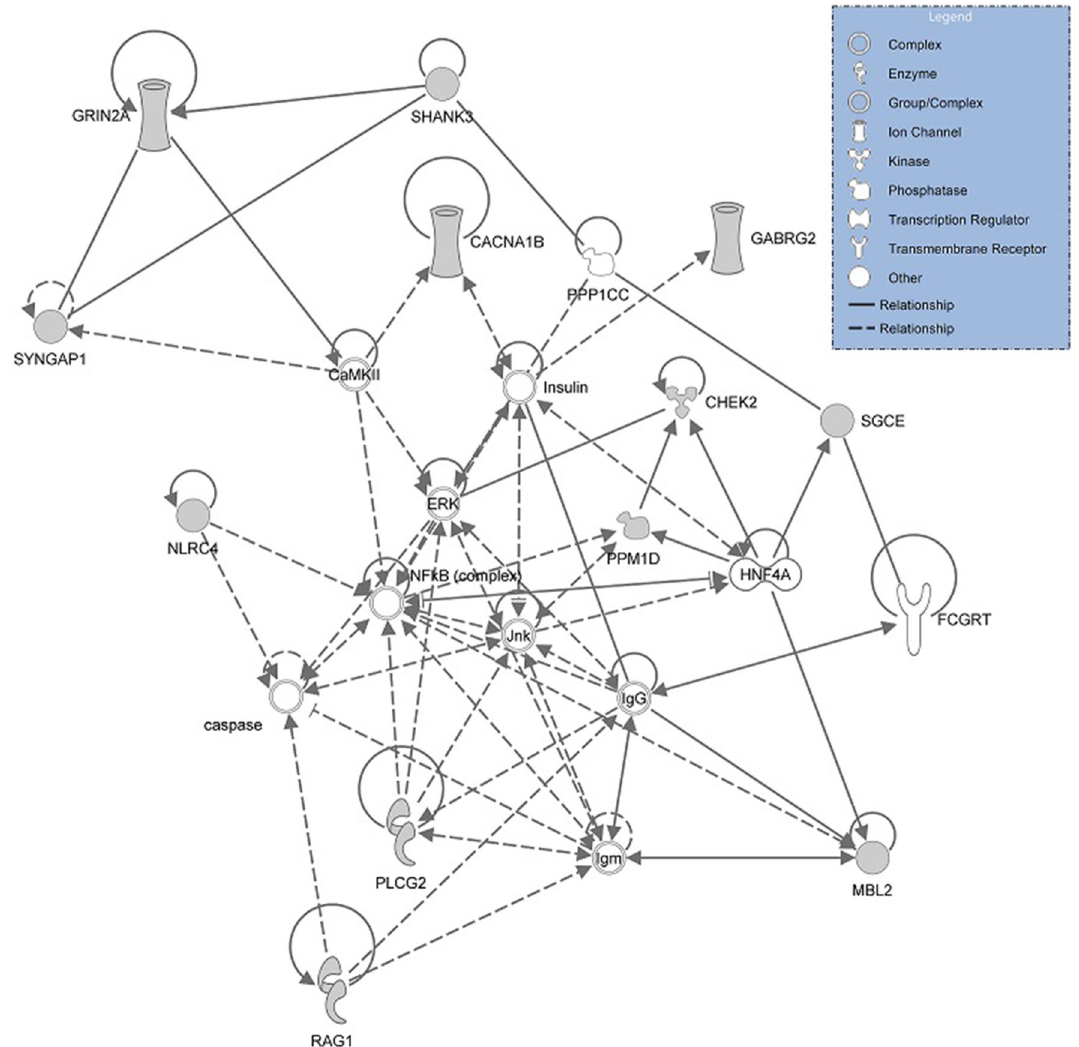
Figure 2. Connectivity network. A connectivity network was generated for each candidate gene using IPA software. Central to the network is the NF-κB complex transcriptional regulator hub, which connects to PPM1D, PLCG2, NLRC4, RAG1, BID, and CHK2. The PANS candidate genes not directly connected to NF-κB expression are those that are primarily expressed in the brain and cause neurodevelopmental disorders (CACNA1B, SYNGAP1, GRIN2A, SGCE, GABRG2, and